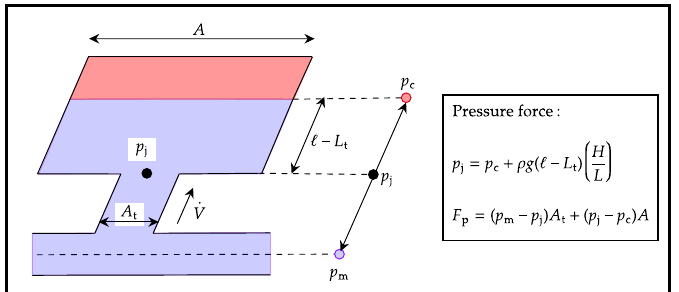
Figure 2. Considering junction pressure p j for evaluating the overall pressure force F p in the direction of flow. p j is the pressure calculated based on the sum of air pressure p c and hydrostatic pressure due to liquid-level h − H t .